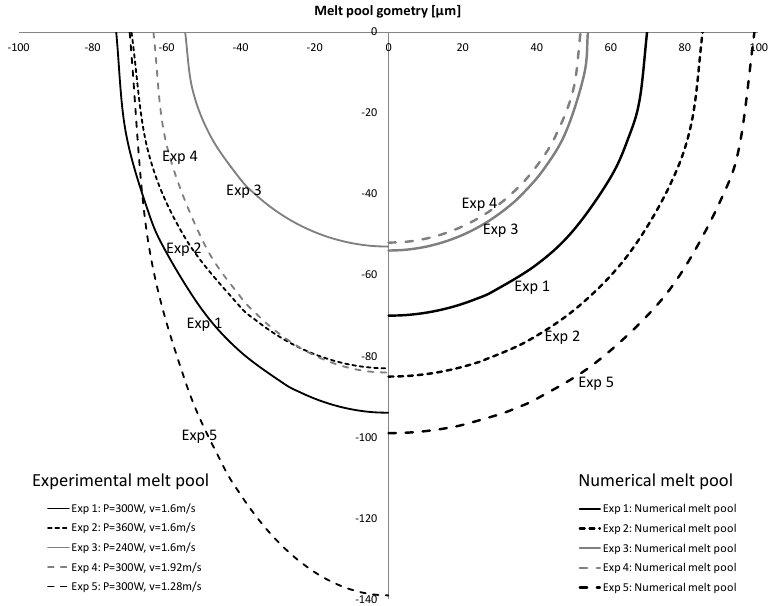
Figure 8. Comparison of the numerical melt pool cylindrical shape ( right ) vs. the measured melt pool dimensions ( left ) for the five sets of experiments.